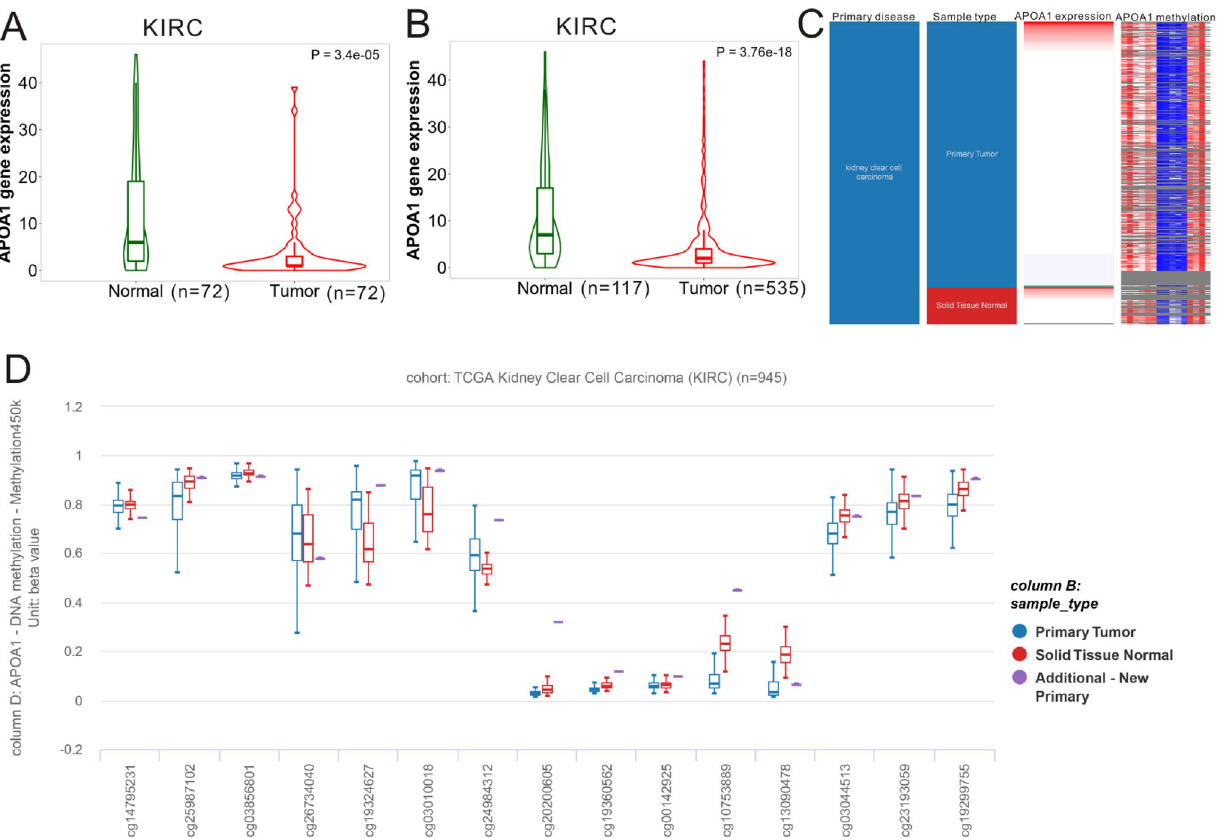
by TNMplot (https:// tnmpl ot. com/ analy sis/). ( B ) The levels of APOA1 mRNA in KIRC tissues were statistically lower than that in the normal renal tissues ( p = 3.76e−18) by TNMplot (https:// tnmpl ot. com/ analy sis/). ( C ) UCSC Xena webpage (http:// xena. ucsc. edu/# overv iew) was browsed to generate the heatmap of APOA1 mRNA expression and DNA methylation in KIRC dataset. ( D ) Distribution of APOA1 DNA CpG site among primary tumors, normal tissues and additional-new primary tumors was obtained from UCSC Xena webpage (http:// xena. ucsc. edu/# overv